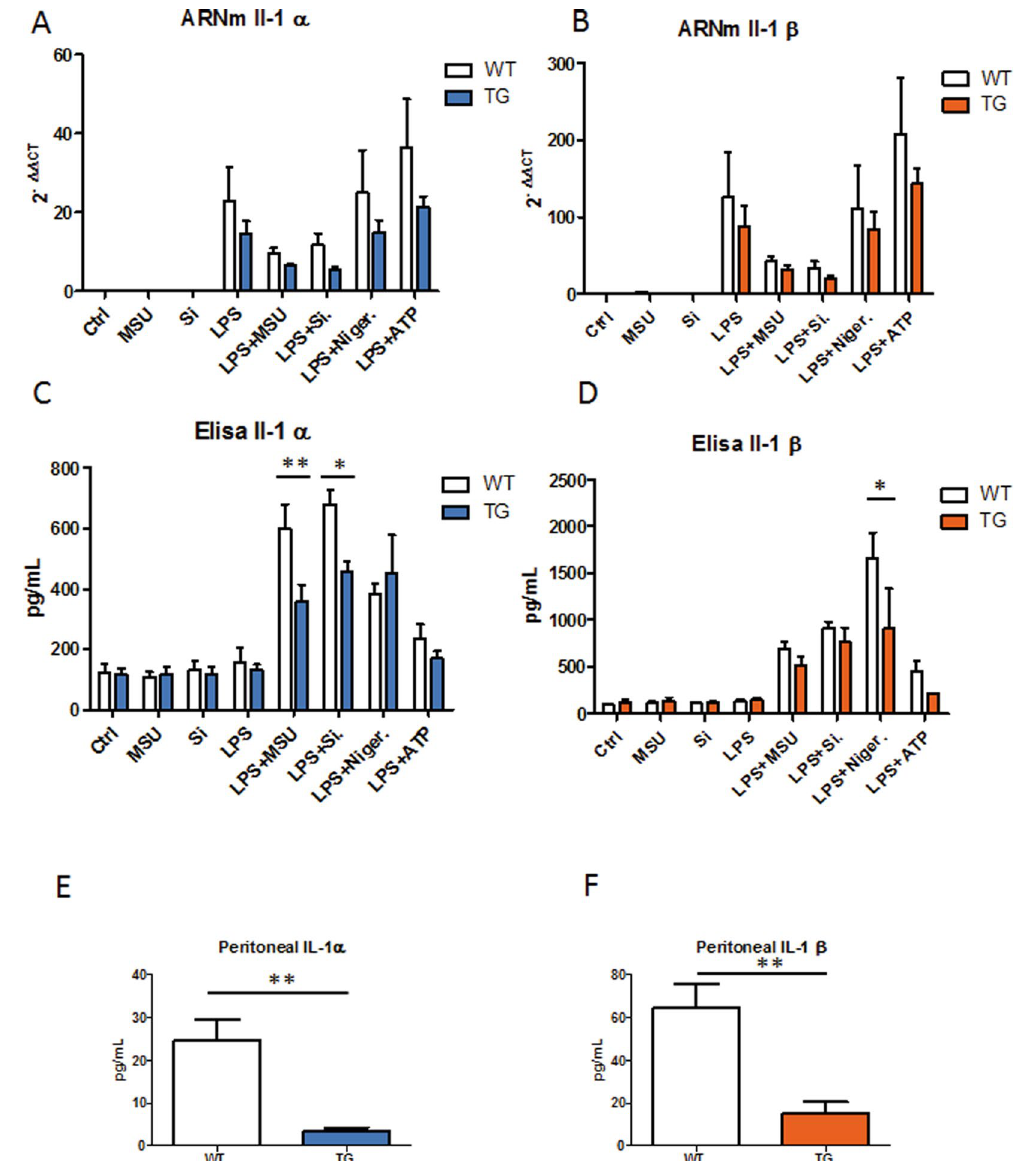
Figure 11. Calpastatin overexpression inhibits IL-1 α and Il-1 β synthesis in vitro and in vivo . In vitro , macrophages isolated from WT and CalpTG (TG) mice bones have been exposed to sodium urate crystals (MSU), Silica crystals (Si.), Adenosine TriPhosphate (ATP) or Nigericin (Niger.), with or without priming by Lipopolysaccharides (LPS). IL-1 α and IL-1 β expression at the mRNA level was globally reduced (ANOVA) by calpastatin overexpression ( A,B , n = 4/condition). Similarly, IL-1 α and IL-1 β cytokine production by macrophages was also globally reduced by calpastatin overexpression, especially IL-1 α synthesis after exposure to particulate inflammasome activators MSU and Si. ( C,D , * p < 0.05, ** p < 0.01 (post test), n = 4/condition). In vivo , MSU crystals have been injected to WT and CalpTG (TG) mice intraperitonally. IL-1 α and IL-1 β cytokines have been measured early (3 hours) in the peritoneal fluid, their synthesis was dramatically reduced in CalpTG mice ( E,F , ** p < 0.01, n =